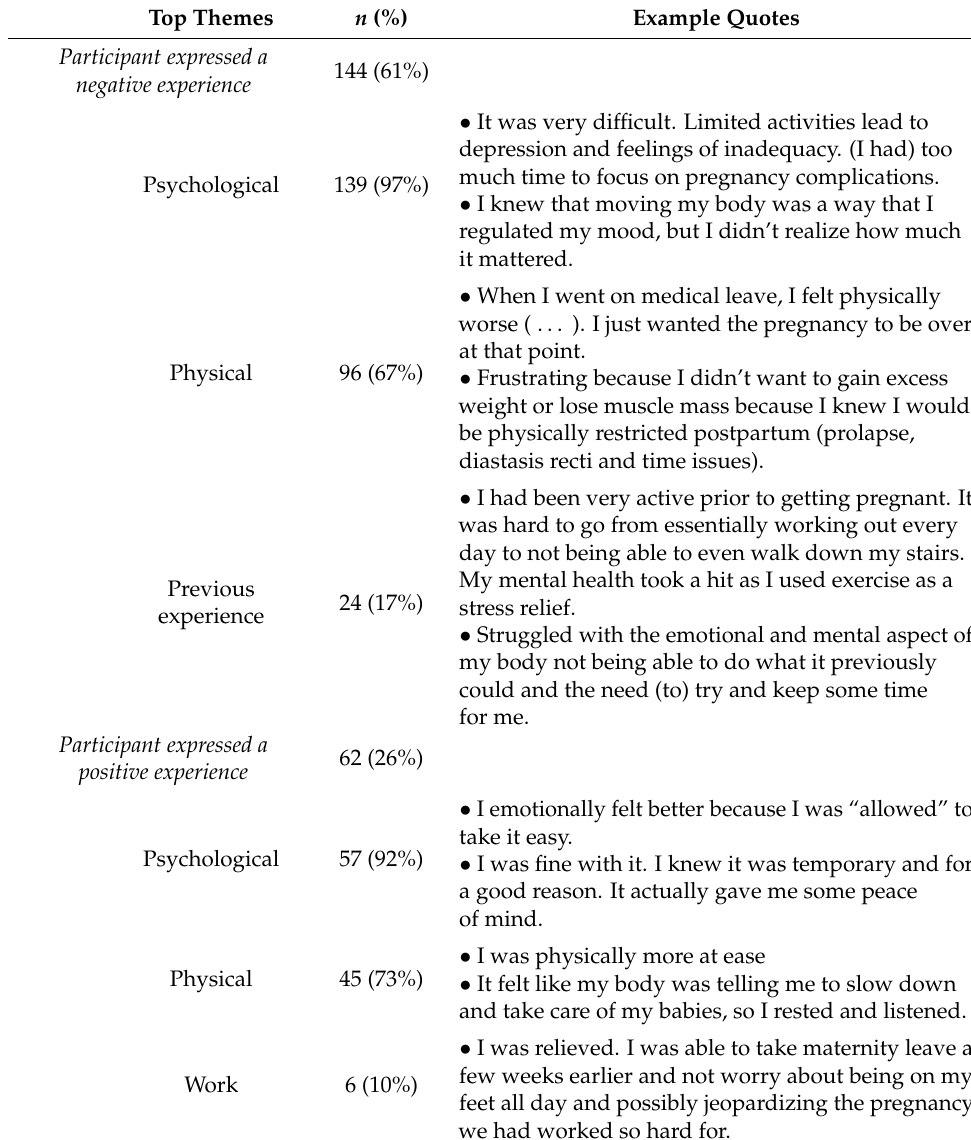
Table 4. Experience and prominent themes related to activity restriction in multifetal